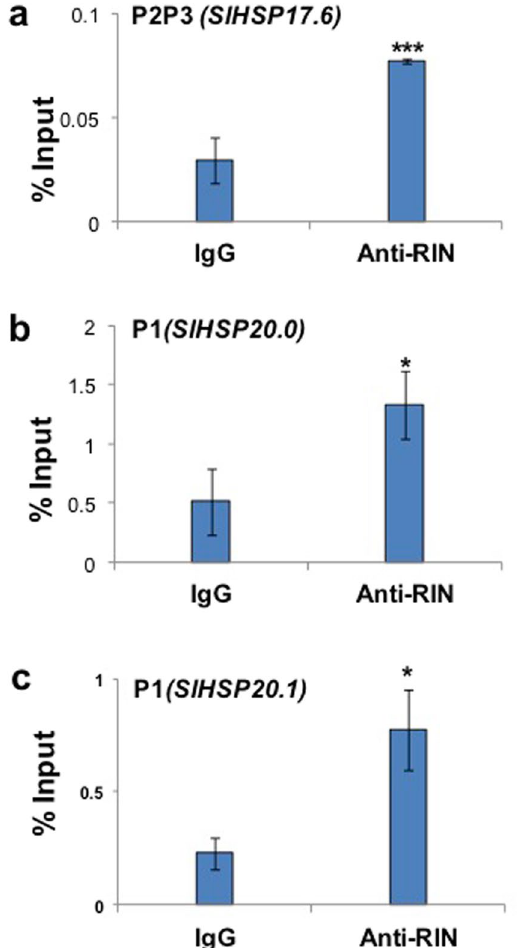
Figure 6. Chromatin immunoprecipitation (CHIP) and quantification of enrichment using CHIP-qPCR. Breaker stage Ailsa Craig tomato fruits were analyzed for chromatin cross linking. Plant CHIP Kit (Epigentek) was used for CHIP assays according to manufacturer’s instructions with few modifications 43 . Graph bars represent the relative DNA amounts of CArG-box sequences in the CHIP DNA recovered using either anti-RIN antibody or IgG antibody to those in the total input chromatin DNA. Data are the means of three independently prepared chromatin samples. Error bars indicate the standard deviation of each mean where n = 3. Rabbit IgG was used as a negative control. Asterisks indicate statistically significant differences, P <